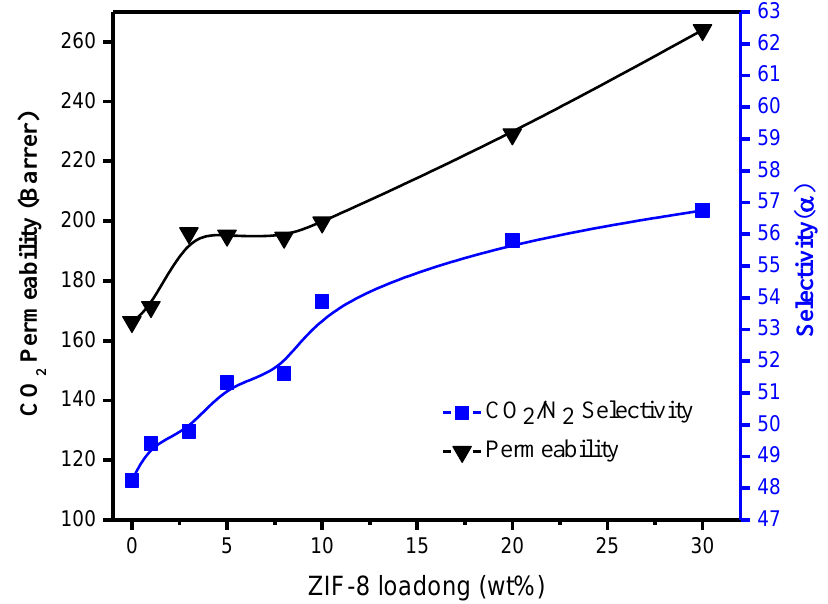
Figure 5. Pebax/n wt% ZIF-8 MMMs gas permeability and gas separation selectivity performance.